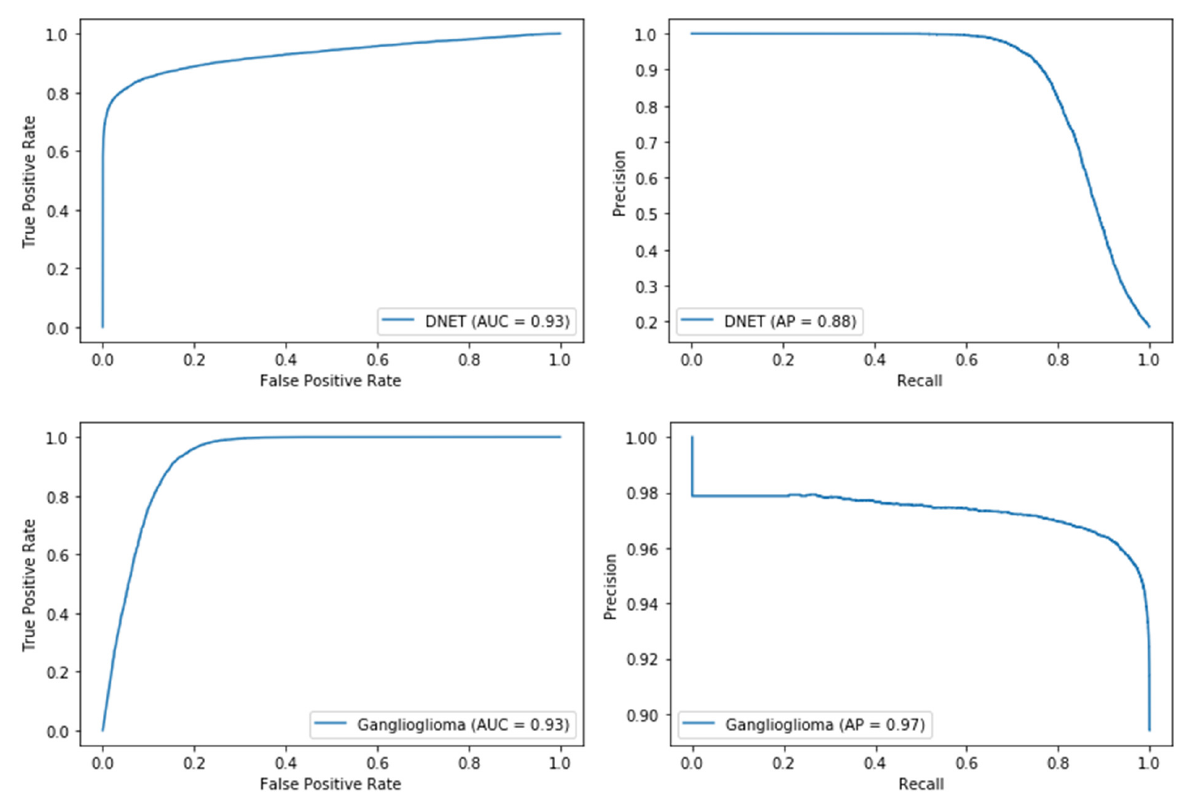
Figure 7. Results | ROC ( left ) and precision recall curves ( right ) on tile level.